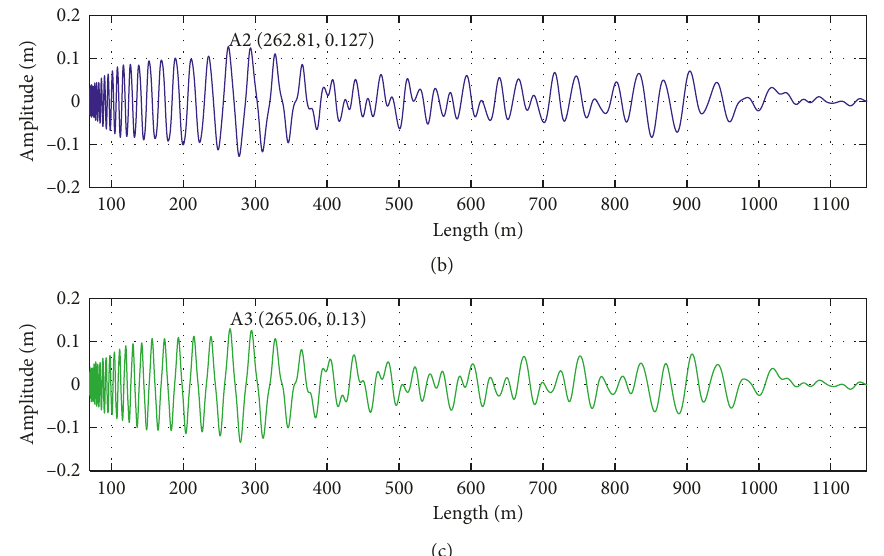
Figure 25: Variation in the resonance region at the midpoint of the lifting rope. (a) Terminal tension � 2 × 10 4 N, (b) terminal tension � 5 × 10 4 N, and (c) terminal tension � 1 × 10 5 N.